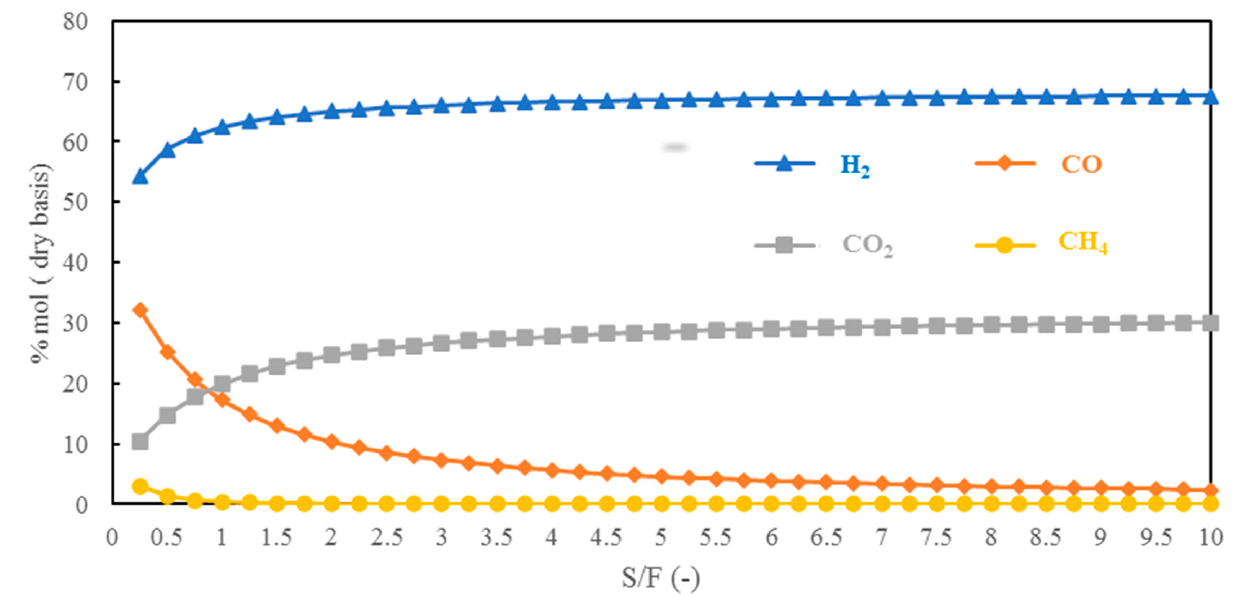
Figure 4. Effect of the S/F mass ratio on the gas product composition exited from a gasifier at a gasifier temperature = 700 ◦ C, CaO/F mass ratio = 1, carbonator temperature = 450 ◦ C, and regenerator temperature = 950 ◦ C.